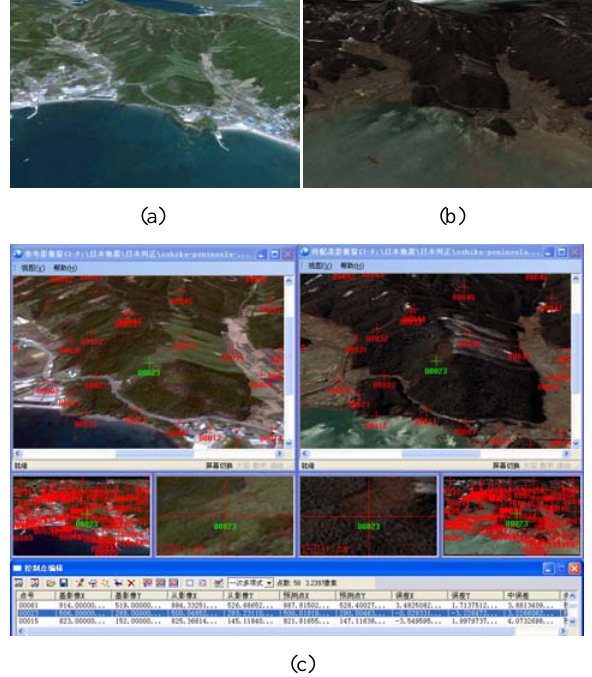
Figure.3Geometric Pre-processing, (a)Yagawahama in Miyagi Before Disaster (b)Yagawahama in Miyagi After Disaster, (c) Interface of Image Registration with SIFT Automatic Matching